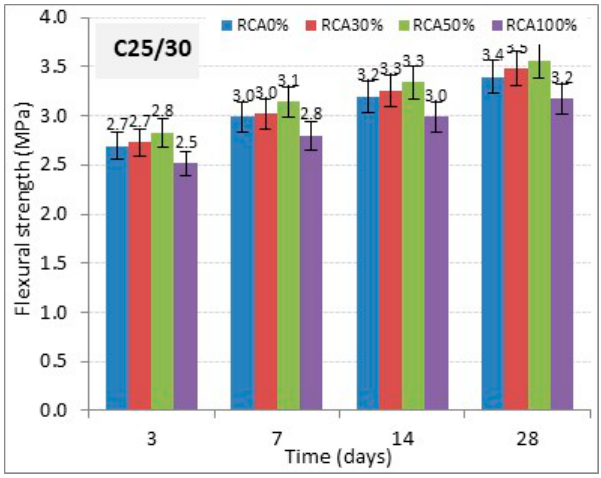
Figure 9. Effect of RCA content on the flexural strength development for C16/20 concretes. Figure 9. E ff ect of RCA content on the flexural strength development for C16 / 20 concretes. Buildings 2020 , 10 , x FOR PEER REVIEW